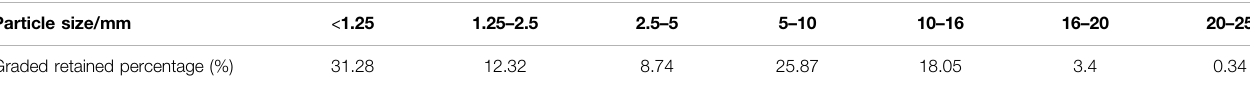
TABLE 8 | Laboratory gradation table of mixed- fi lling gangue.